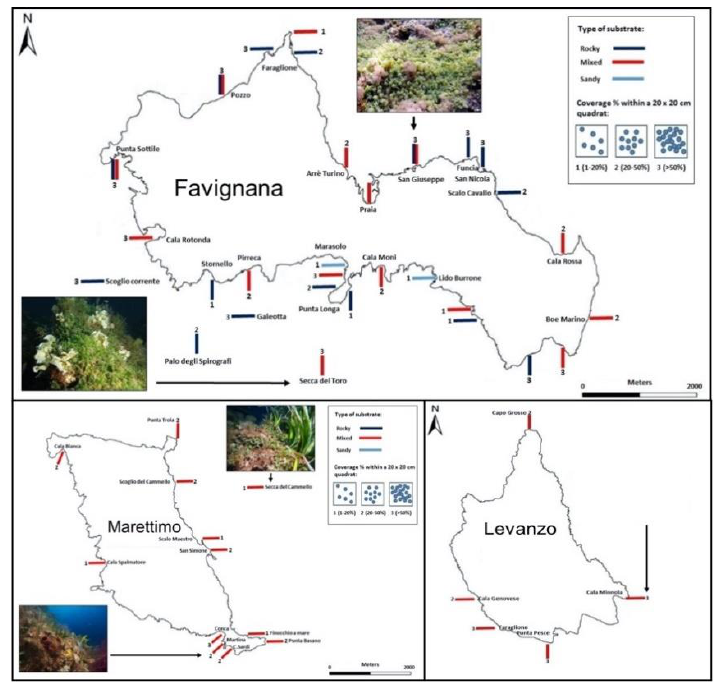
Figure 2. Occurrences of Caulerpa cylindracea within the Egadi Islands marine protected area (MPA) (modified from Reference [55]).